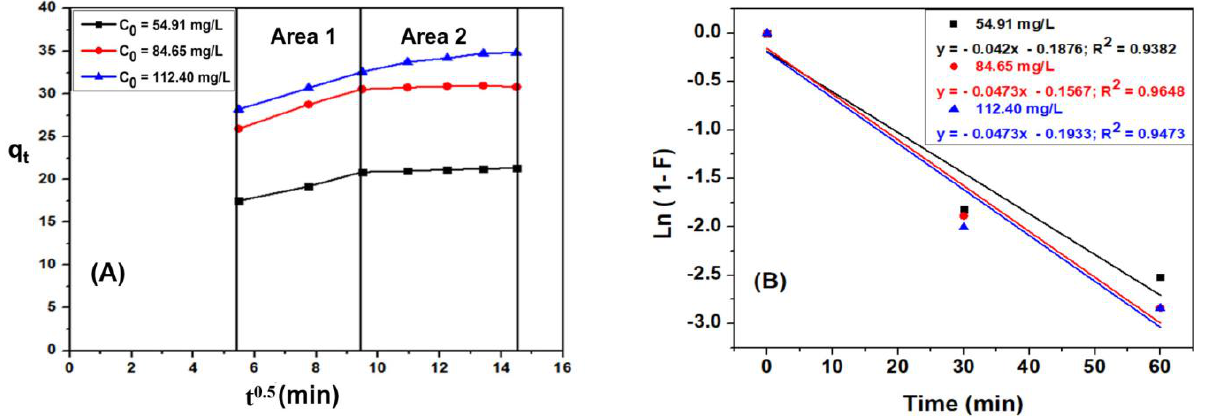
16 of 19 Figure 12. ( A ) The pseudo − first-order adsorption kinetics equation and ( B ) The pseu- do-second-order adsorption kinetic equation . From Table 6 and Figure 12B, the coefficient of determination R 2 is above 0.99. Be- sides, the equilibrium adsorption capacity values calculated from the kinetic equations are highly close to the experimental values. Besides, the values of the reactivity constants are approximately the same. Therefore, it can be concluded that the pseudo-second- or- der adsorption kinetic equation is suitable for the MB adsorption process by ACDS. The intraparticle diffusion models of Weber and Morris shown in Figure 13A illus- trated that the time-dependent q t plot t 0.5 is divided into 2 regions. Region 1 is attributed to diffusion of the adsorbent in solution to the outer surface of the adsorbent (external surface adsorption). Region 2 describes the adsorption phase, where intra-particle diffu- sion determines the rate of adsorption. Figure 13A also demonstrated that at high con- centrations (112.40 mg·L −1 ), the graph of the dependence of qt on t 0.5 in region 2 indicates